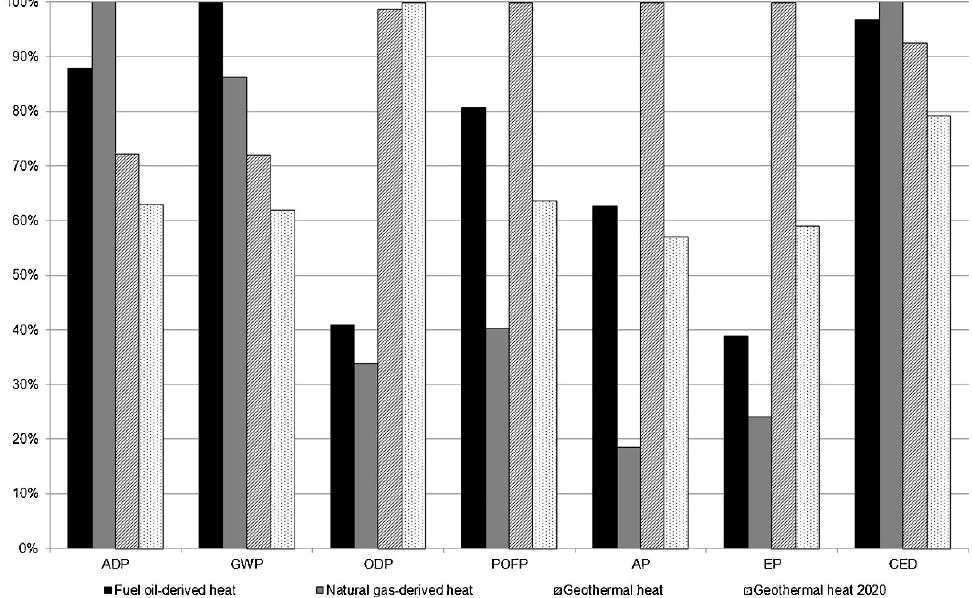
Figure 8. Comparison of the environmental impacts of geothermal heat and fossil-derived thermal energy for the studied technologies [40].